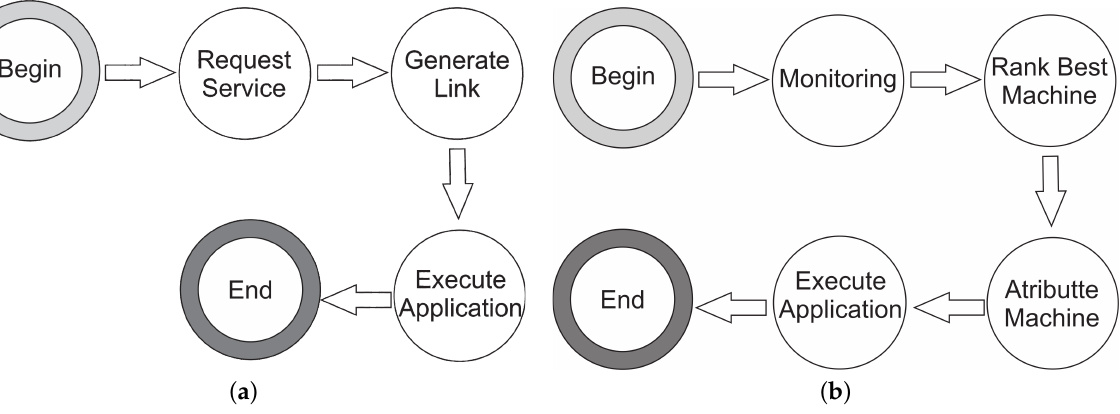
Figure 3. Flow of the system. ( a ) Client interaction flow, ( b ) Flow of internal server processes.